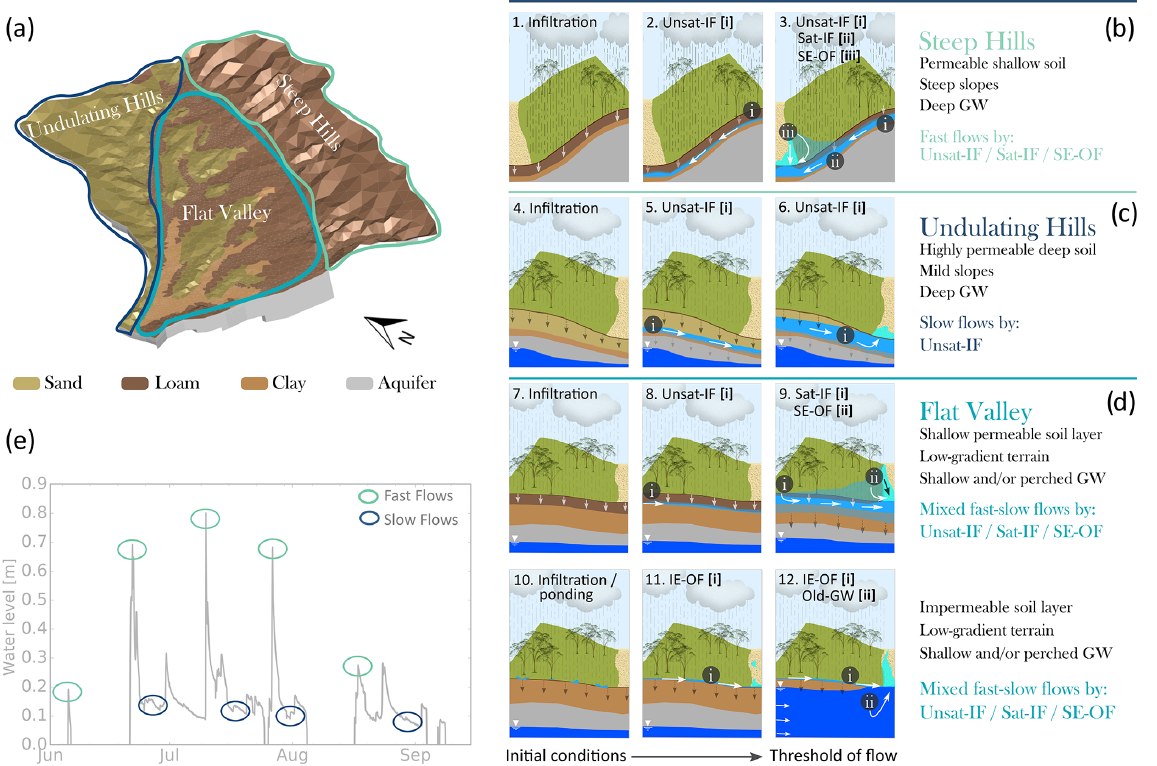
Figure 3. (a) Conceptual diagram showing the three major areas that are likely to develop distinct streamflow generation mechanisms during the intermittent flow season. (b–d) The 2D soil profiles for the three major areas detailing the processes developing from the initial conditions until the threshold of flow (modified from Gutierrez-Jurado et al., 2019). (e) Typical hydrograph during the intermittent season highlighting the hypothesised fast and slow flow components. For illustration purposes, the aquifers are presented as a single unit depicted in grey. Arrows represent the flow